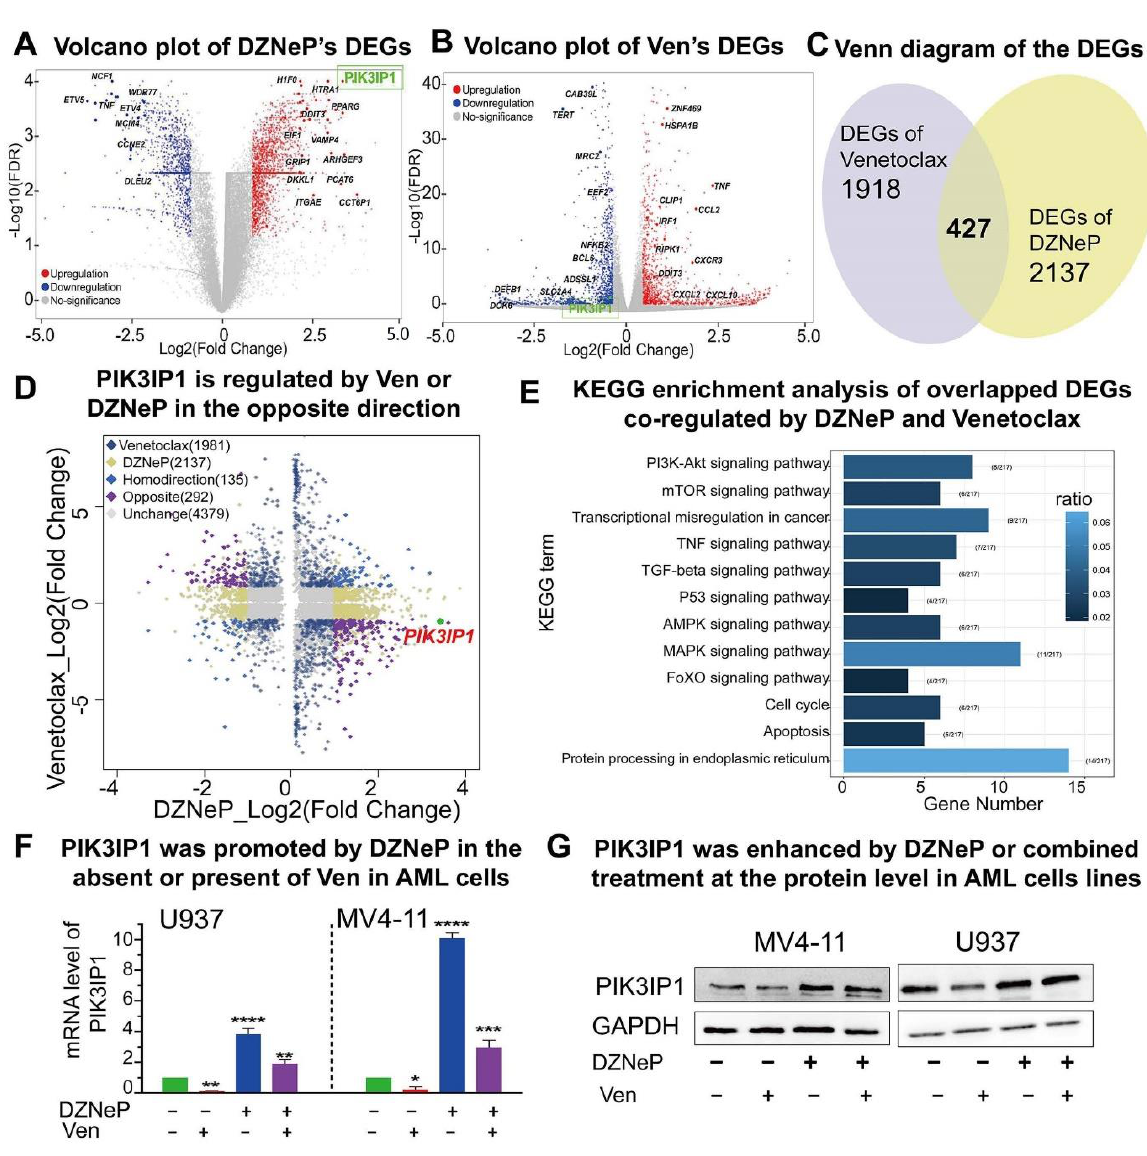
significant differentially expressed genes (DEGs) were identified in the cells upon Ven treat- ment compared to the vehicle control, and 2564 DEGs upon DZNeP treatment (Figure 3A,B), in which 427 were overlapped (135 genes changed in the same direction and 292 in the opposite) (Figure 3C,D). KEGG enrichment analysis of the overlapped DEGs showed the significant enrichment of genes in multi-oncogenic signaling (PI3K/AKT/mTOR, MAPK, etc.), the cell cycle progress, and the apoptosis signaling pathway (Figure 3E).